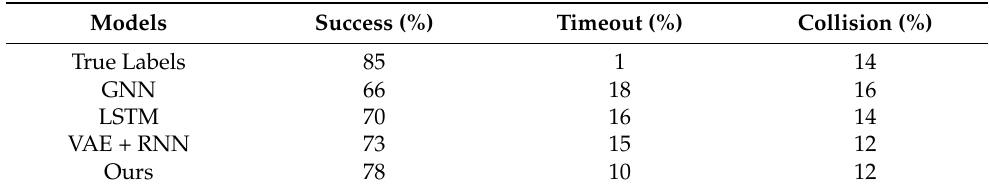
Table 1. Objective evaluation decision results of self-driving strategies with aggressive drivers p = 0.25.